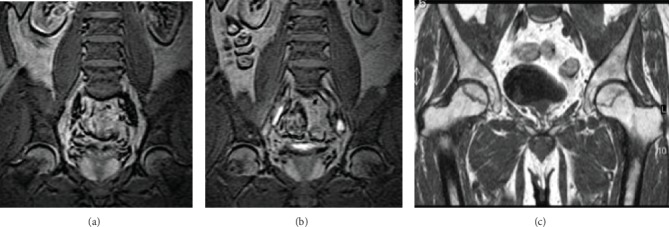
A 64-year-old male developed ONFH after DBRs treatment for 1.6 months. (a, b) Coronal magnetic resonance image before DBRs. (c) Coronal magnetic resonance image after cumulative dose of 200 mg dexamethasone for 1.6 months. ONFH: osteonecrosis of femoral head; DBRs: dexamethasone-based regimens.